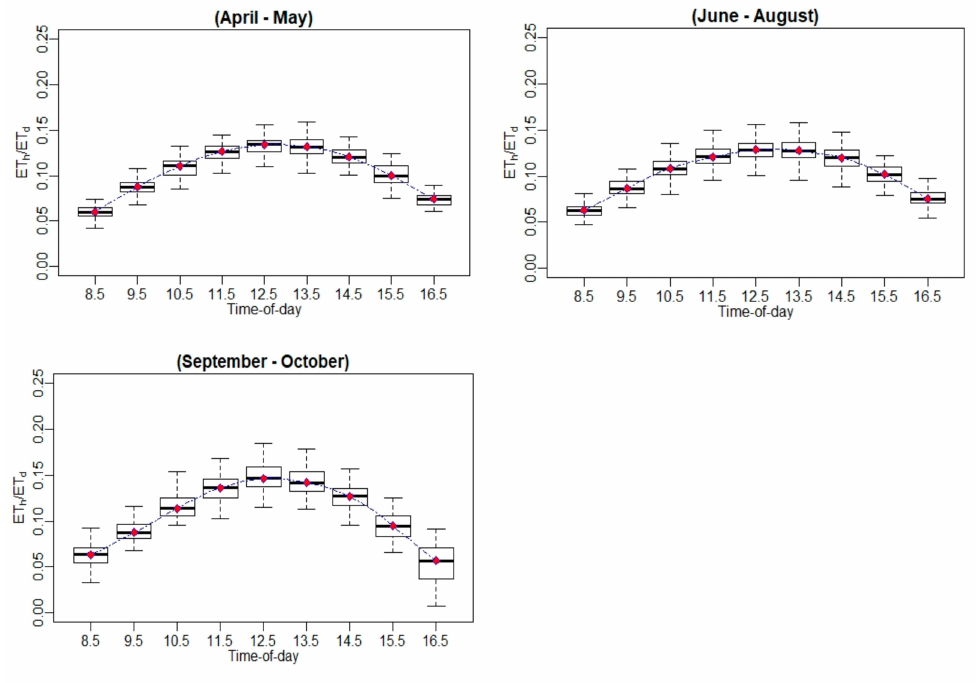
Figure A7. Hourly ET to daily ET ratio ( ET h /ET d ) variation using EC measurements.